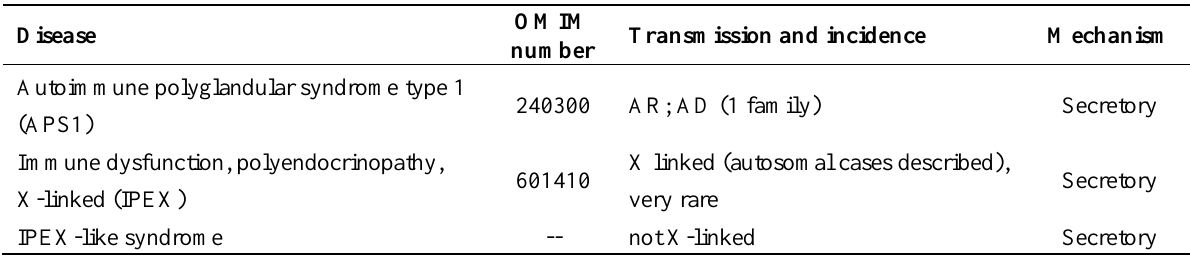
Table 4. Inheritance, epidemiology and main pathological mechanisms of the defects of modulation of intestinal immune